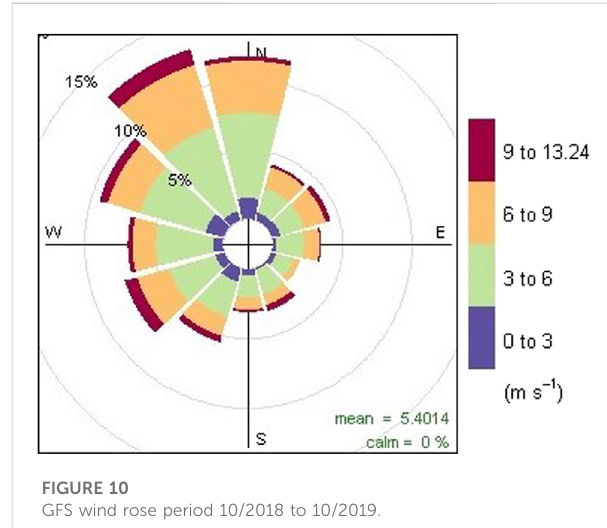
GFS wind rose period 10/2018 to